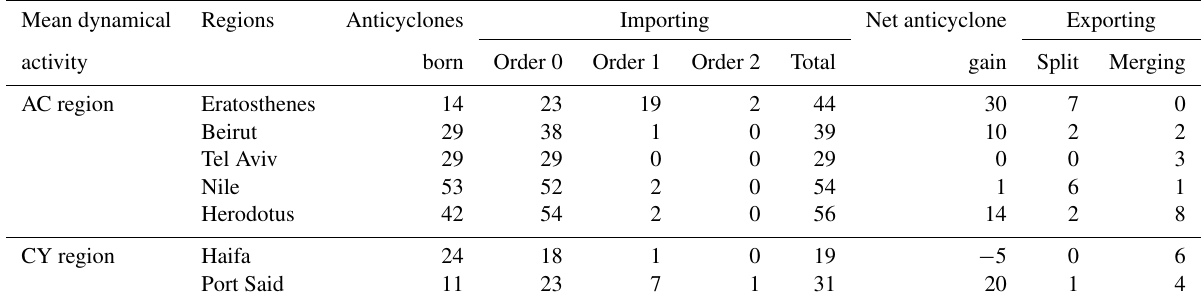
Table A2. Details of importing and exporting anticyclones for the seven regions of the southeastern LB identified in Sect. 3.2. Details are also shown in Fig. 6a–g, and the net anticyclone gain appears in Fig.